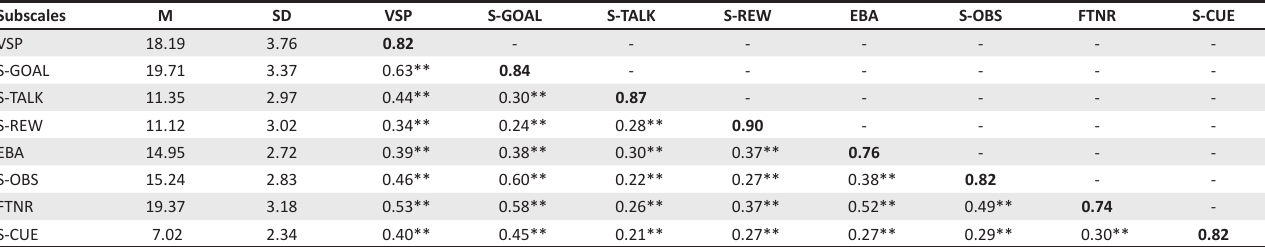
TABLE 2: Descriptive statistics and inter-correlations of subscale scores of the revised self-leadership questionnaire. Subscales